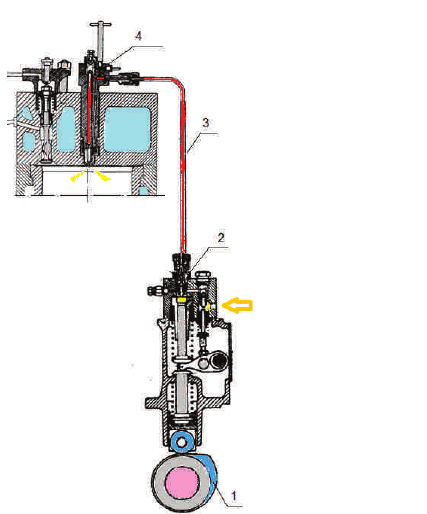
Fig. 1. Scheme of the injection subsystem of the four-stroke internal combustion engine: 1 – fuel cam, 2 – delivery valve, 3 – injection line, 4 – injector valve Table 1. The main specifications of test injection subsystem On.